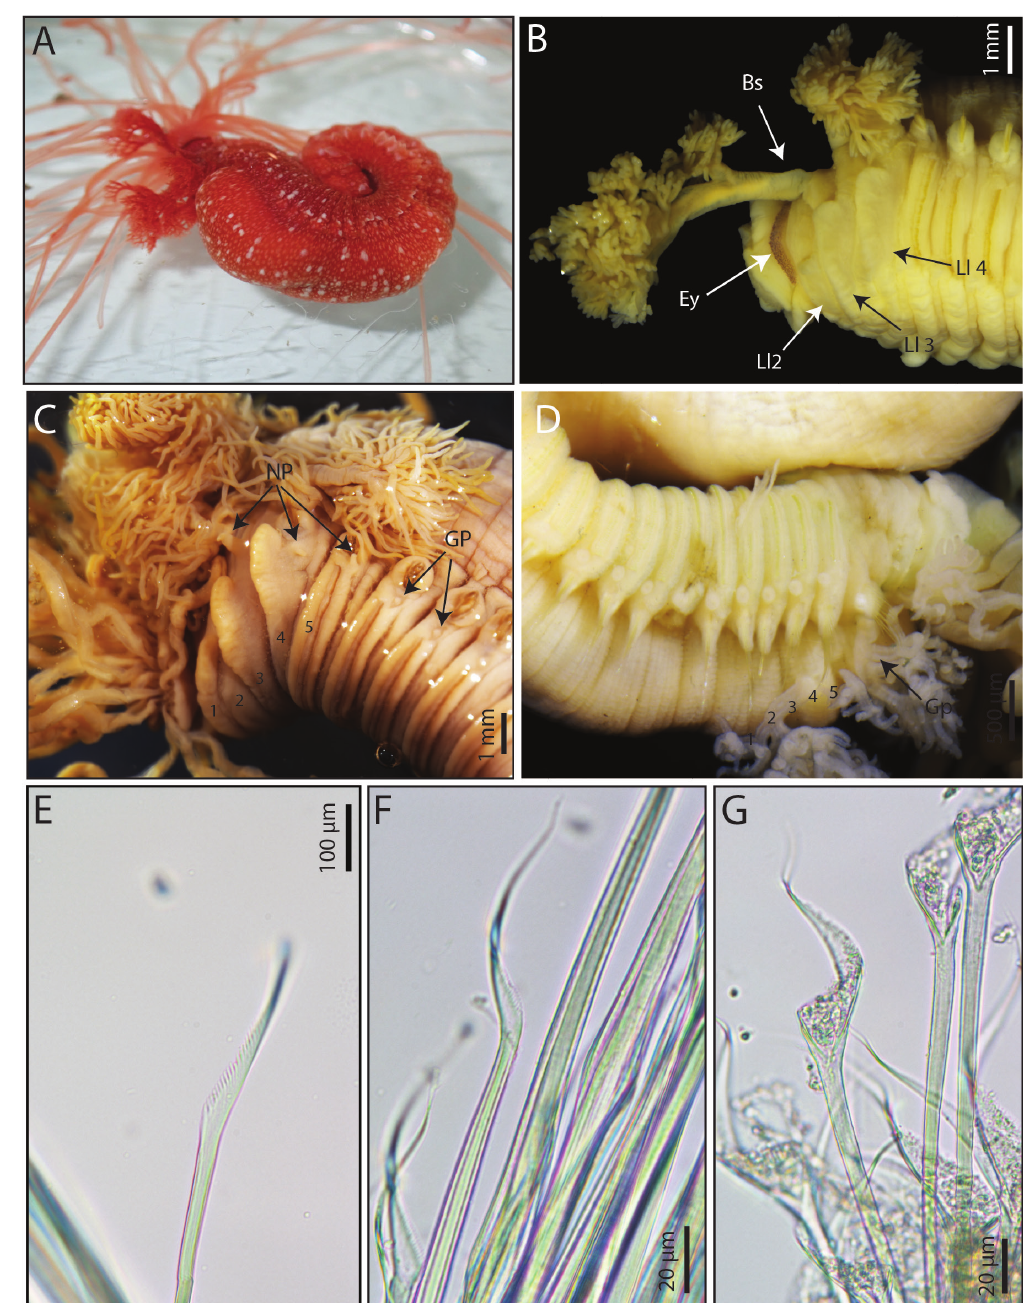
Fig. 5. Diversity of Terebellidae Johnston, 1846 (s.s . ). A . Eupolymnia lacazei Lavesque, Daffe, Londoño-Mesa & Hutchings, 2021, live specimen (paratype MNHN-IA-TYPE 2023). B . Eupolymnia gili Lavesque, Daffe, Londoño-Mesa & Hutchings, 2021, anterior end, lateral view (holotype MNHN- IA-TYPE 2020). C . Amphitrite edwardsii (Quatrefages, 1866), anterior end, lateral view (MNHN-IA- PNT 126). D . Terebella banksyi Lavesque, Daffe, Londoño-Mesa & Hutchings, 2021, anterior end, lateral view (holotype MNHN-IA-TYPE 2037). E . Paramphitrite dragovabeci Lavesque, Daffe, Londoño-Mesa & Hutchings, 2021, notochaeta, SG XI (paratype MNHN-IA-TYPE 2030). F . Terebella cf. lapidaria Linnaeus, 1767 , notochaetae, SG IX (MNHN-IA-PNT 131). G . Terebella lapidaria, notochaetae, posterior segments (MNHN-IA-PNT 131). Abbreviations: Bs = branchial stem; Ey = eyes; Gp = genital papillae; Ll = lateral lobes; Np = nephridial papillae. Numbers referring to